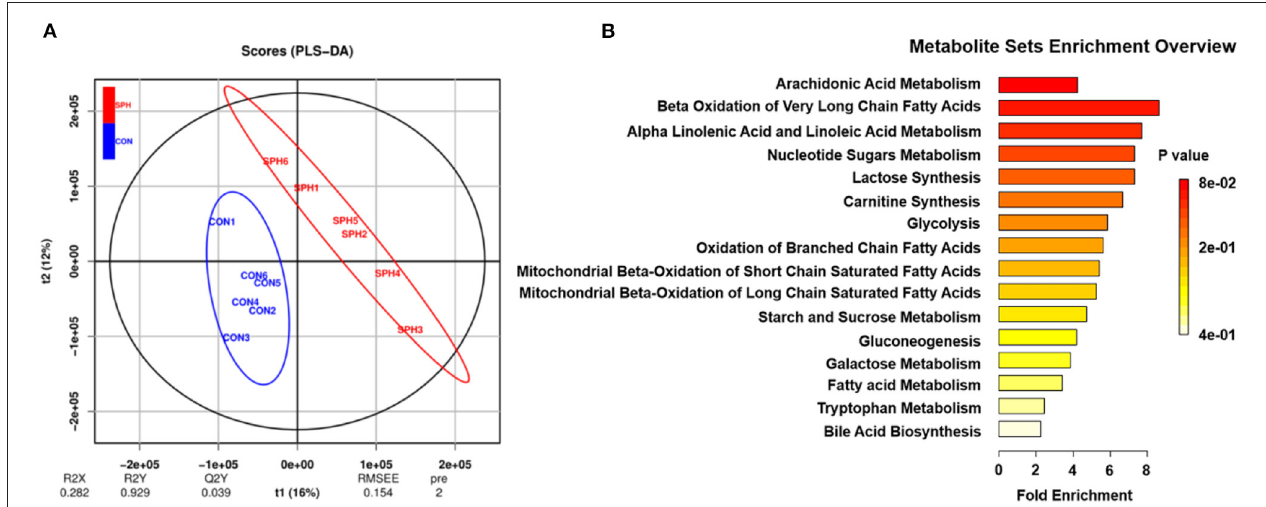
FIGURE 1 | Liver metabolome of the CON and SPH groups. (A) PLS-DA of metabolites (n = 6). t1 explains 16% of the variation; t2 explains 12% of the variation. (B) Metabolite set enrichment overview map of the differential metabolites (VIP > 1.0 and P < 0.05) screened. The color of the rectangle indicates the P -value and its length indicates the pathway impact values. Longer length and darker colors indicate greater pathway enrichment and higher pathway impact values, respectively.